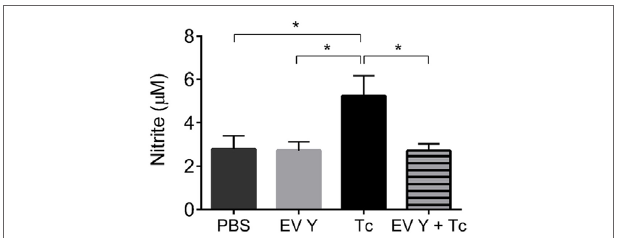
FigUre 4 | Previous inoculation of Trypanosoma cruzi extracellular vesicles (EVs) decreases production of nitric oxide in the peritoneal lavage of T. cruzi -infected mice. C57BL/6 mice were inoculated with EVs derived from T. cruzi Y (EV Y) (i.p.). One week later, the mice were infected with T. cruzi (Tc) by the same route or were inoculated with EV Y alone. Uninfected and PBS- or EV Y-inoculated mice were used as controls. On day 7 after T. cruzi infection and on day 7 after EV Y inoculation in uninfected animals, the peritoneum was washed, and nitrite was quantified in these fluids by the cadmium Griess assay. The results are expressed as the mean ± standard error from 4 to 9 mice per group in an experiment representative of two similar experiments. * P < 0.05 significantly different (one-way ANOVA with Tukey’s post-test)—GraphPad